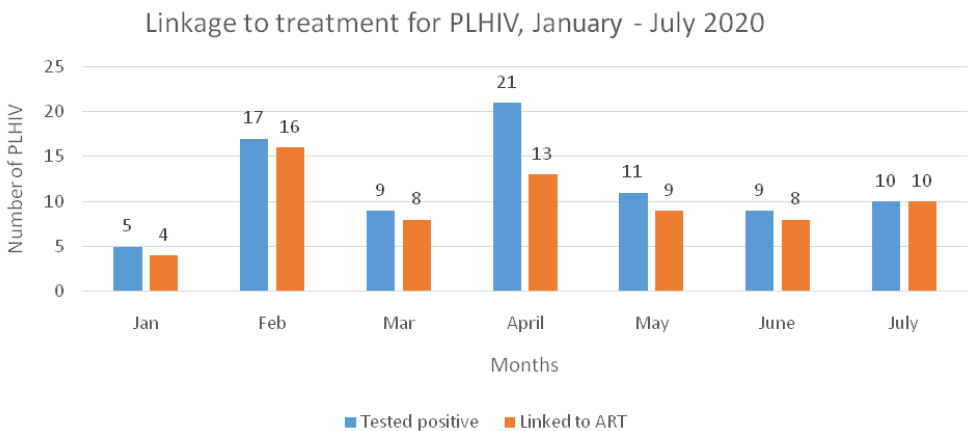
Figure 3. HIV treatment linkage among MSM who are living with HIV, in three sites (combined programme data, Jan – July